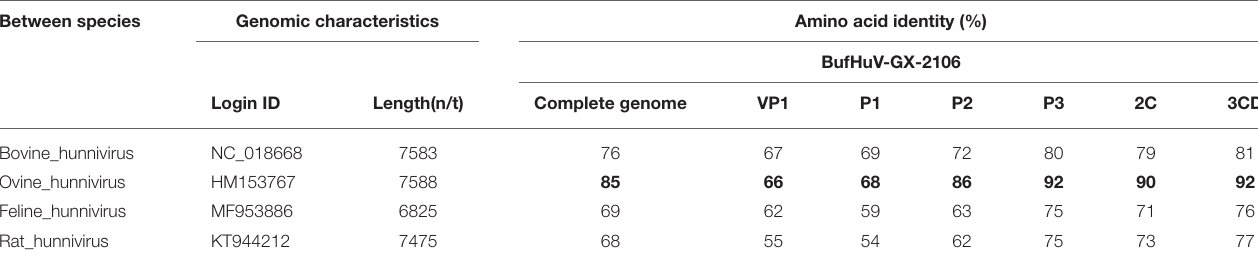
TABLE 1 | A comparative analysis of BufHuV-GX-2106 genome characteristics and other known hunnivirus genomes. Between species Genomic characteristics Amino acid identity (%)